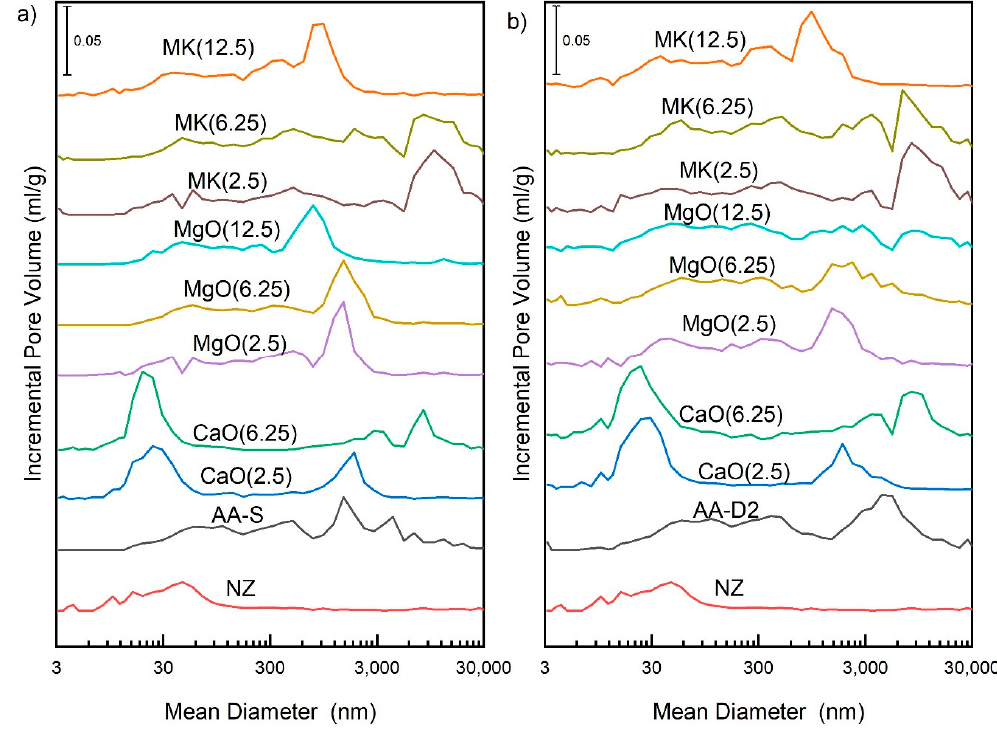
Figure 4. Hg porosimetry of “S” ( a ) and D2 ( b ) samples series.